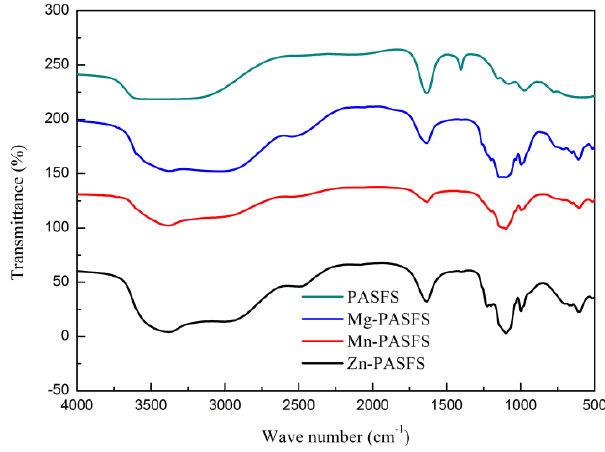
Figure 9. IR spectra of coagulants.